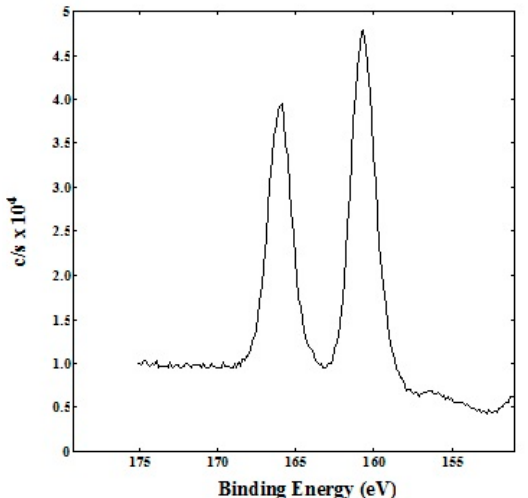
Figure 7. XPS spectrum for the Bi4 f region for the compound Bi 2 O 2 CO 3 :Al. Table 6. Atomic concentrations and assignments for the Bi4 f region for the compound Bi 2 O 2 CO 3 :Al. Bond Energy for